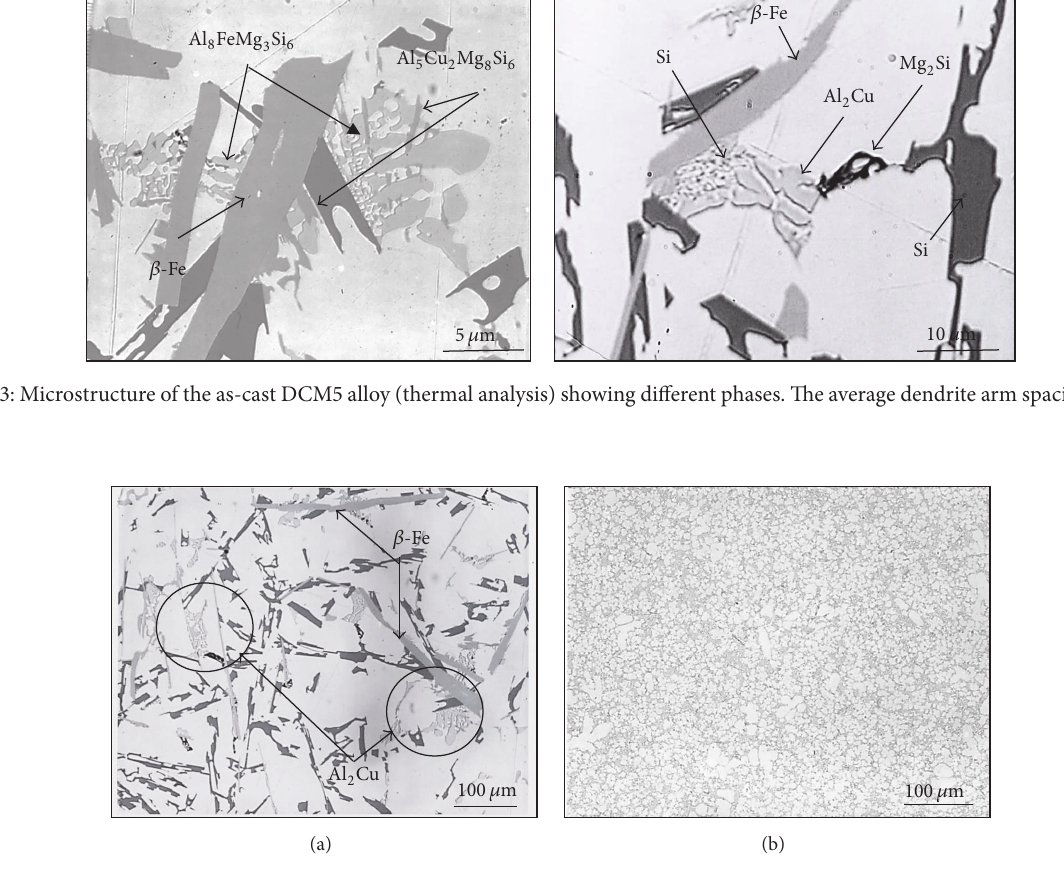
Figure 4: Microstructure obtained from DCM5 alloy: (a) DAS ∼ 85 𝜇 m and (b) DAS ∼ 6 𝜇 m (LPDC).